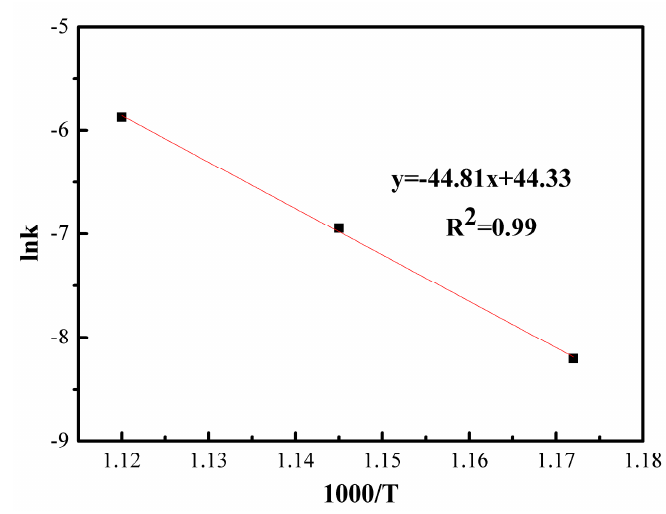
Figure 7. Arrhenius plot for formation of austenite in the 13Cr supermartensitic stainless steel tempered at the range of 580–620 °C.